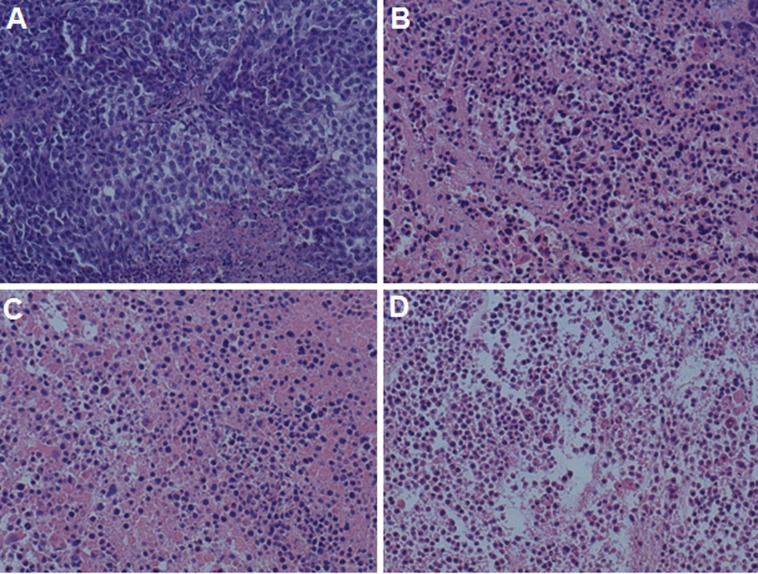
Hematoxylin and eosin (H&E) stained tumor sections isolated from mice on 14th day after various different treatments.Notes: (A) Saline, (B) DOX+PTX, (C) PF-DP and (D) c(RGDyK)-FP-DP. Original magnification: ×20.